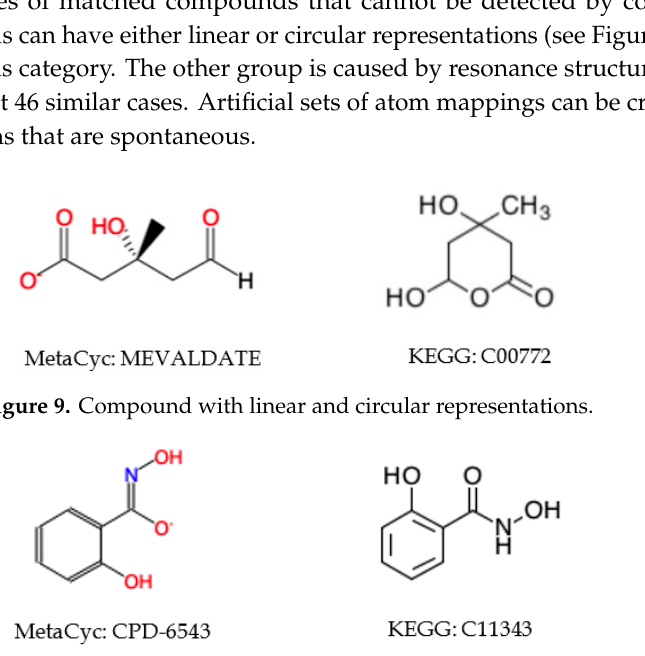
Figure 10. Compound with different resonance structures.